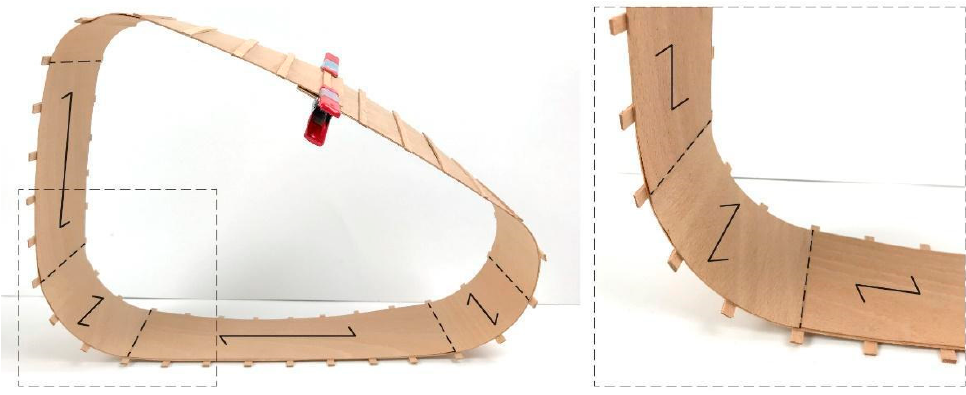
Figure 9. Combination of lamination and bending studies for the application of a chair. Grain direction is highlighted with black arrows.